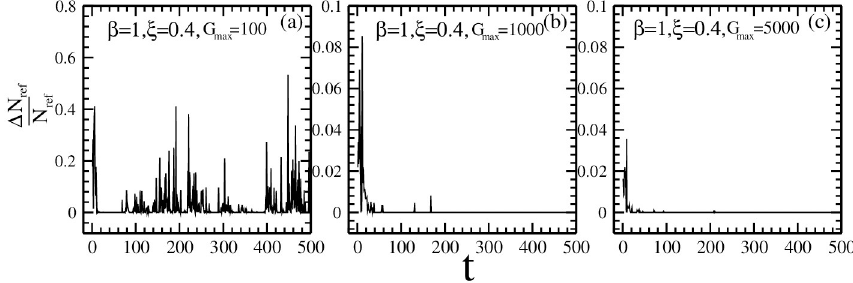
= 100; (b) G = 1000; (c) G = 5000. Other parameters are: the population size N = 5001, the max max max market impact β = 1, the ratio of individuals with reference point strategies ξ = 0.4, the memory size m = 3 and m 0 = 10, , the constant a ¼ 10 , minimum and maximum shares holding k min = -1, k max = 1. The initial 10 N conditions are: an individual’s risk tolerance